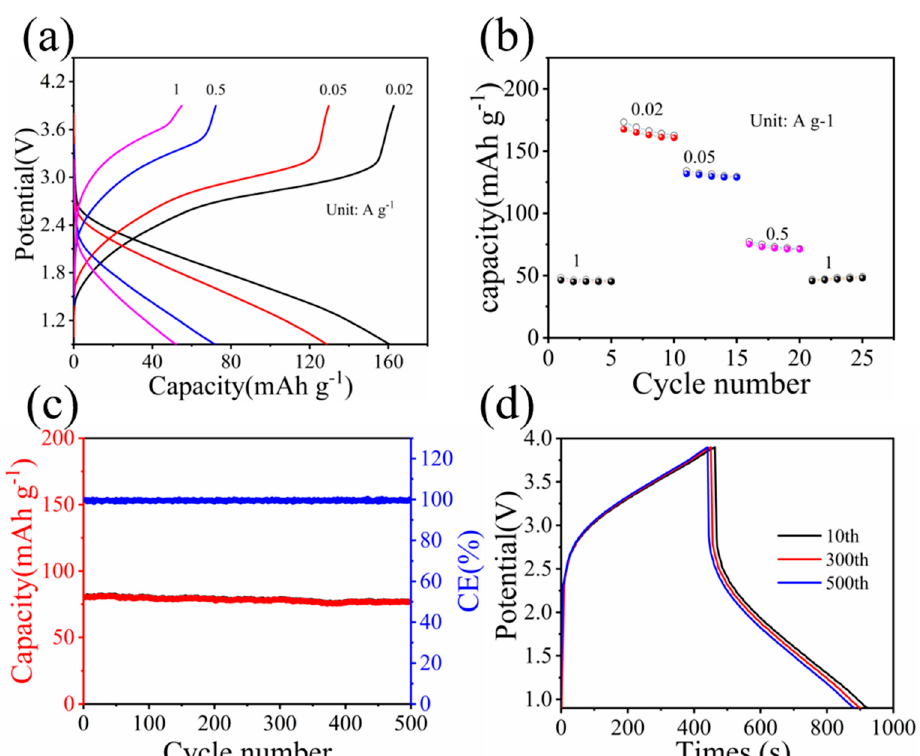
Figure 5. ( a ) GCD curves and ( b ) rate capability of the LiFePO 4 // α -MoO 3 /MXene full cell at different current densities. ( c ) Cycling performance of the LiFePO 4 // α -MoO3/MXene full cell in different cycles at 0.5 A g − 1 . ( d ) GCD curves of the LiFePO 4 // α -MoO 3 /MXene full cell at 0.5 A g − 1